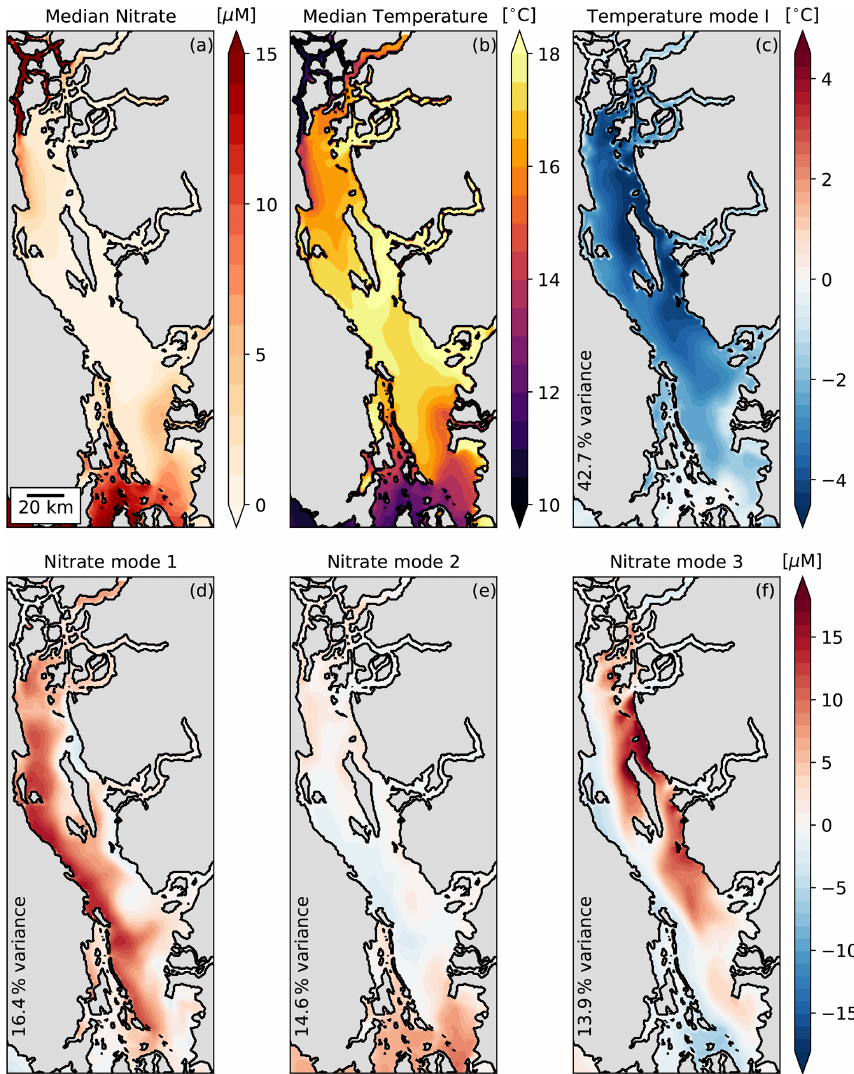
Figure 6. Empirical orthogonal function (EOF) spatial anomalies in order of decreasing percent variance applied to the 2015–2019 Salish- SeaCast surface temperature (c) and nitrate (d–e) records between the seasonal cutoffs shown in Fig. 5. The median surface nitrate (a) and temperature (b) fields between the seasonal cutoffs are also shown. The surface fields are subsampled to 2.5km resolution and de-trended using a 35d high-pass Blackman window filter prior to the principal component analysis (Sect. 2.3.1). The variance explained by each mode is printed in the lower-left corner of each panel. Nearly half of the total variance is distributed approximately evenly across the first three nitrate modes (d–f) , while a similar 42.7% of temperature variance is contained entirely within the first temperature mode (c)